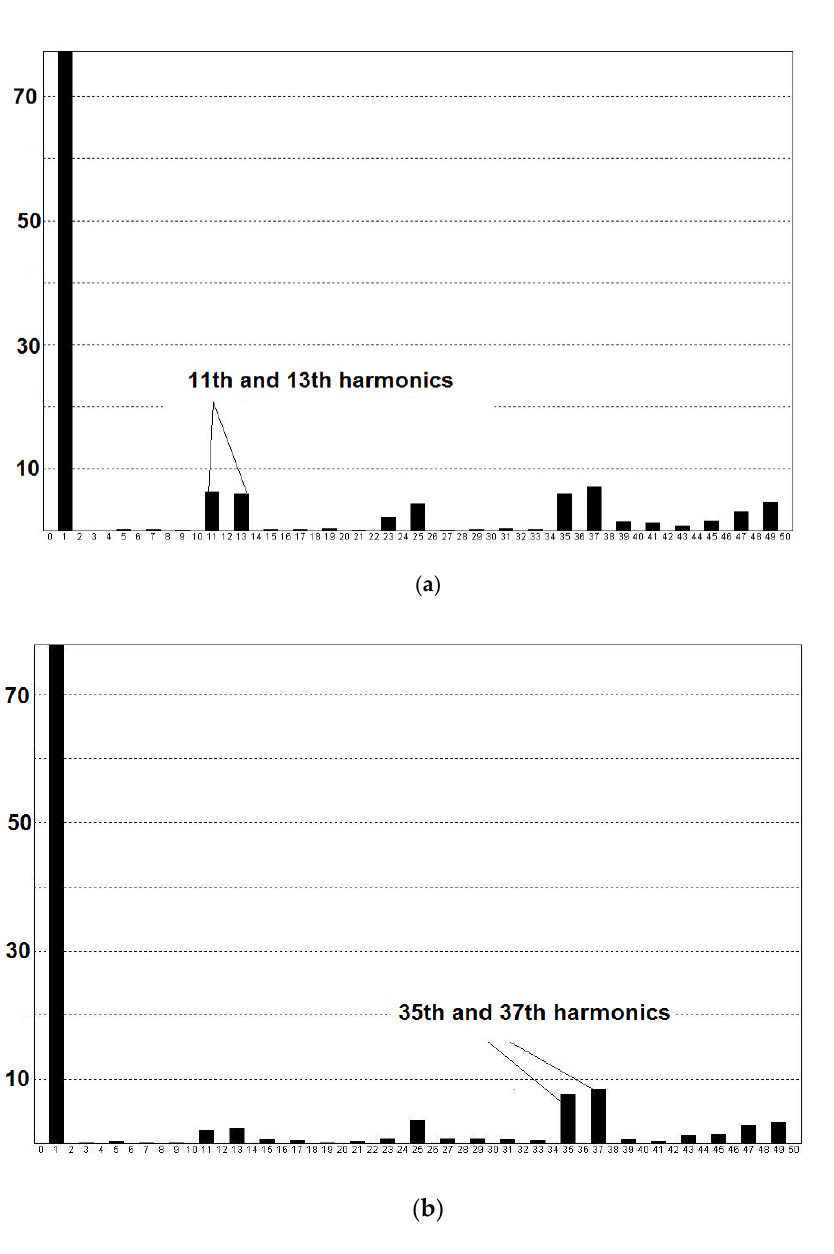
Figure 3. Spectral analyses of the grid current for the rectifier with the voltage modulator: ( a ) the system without the voltage modulator (THD = 15.7%), ( b ) the system with the voltage modulator (THD = 9%).